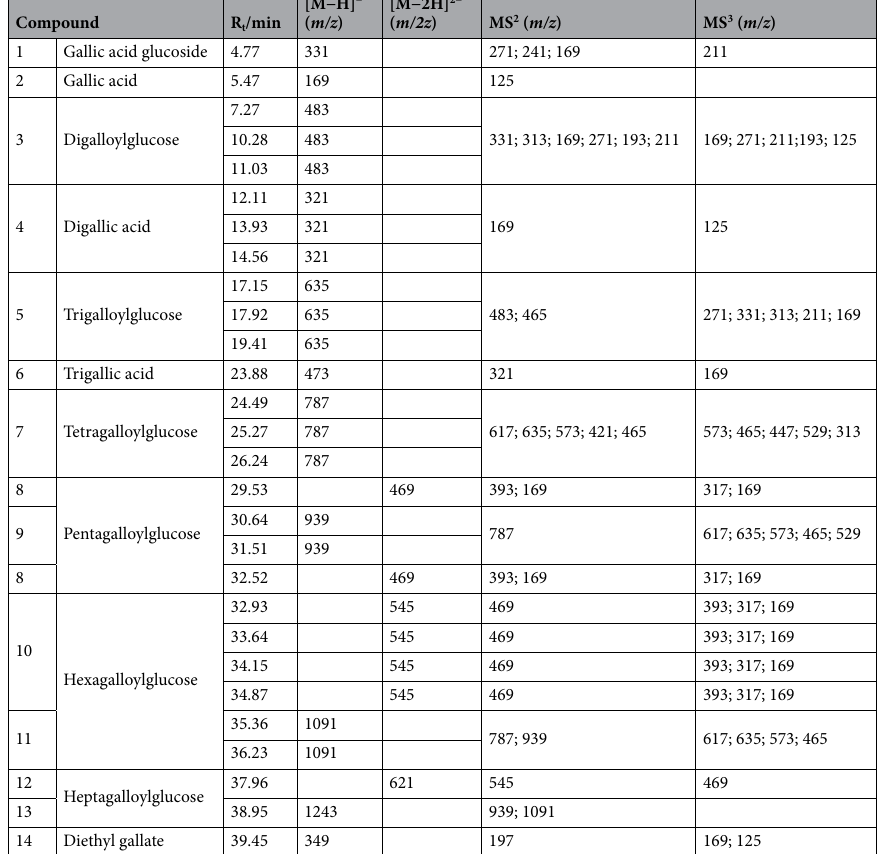
Figure 3 represents the comparison of the concentration of all the phenolic compounds (expressed in mg/ mL of equivalents of gallic acid) identified in all extracts and inks (with and without gum arabic) for all recipes. To simplify, the concentration of isomeric compounds was summed. Table 3 represents the concentration of gallic acid and phenolic compounds present in higher concentration (PGG and HGG), as well as the sum of all